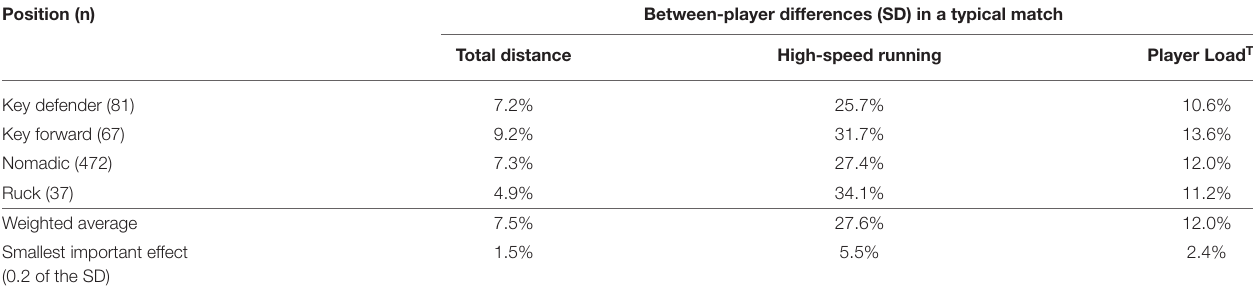
TABLE 2 | The between-player differences in activity profile in a typical match and the smallest important